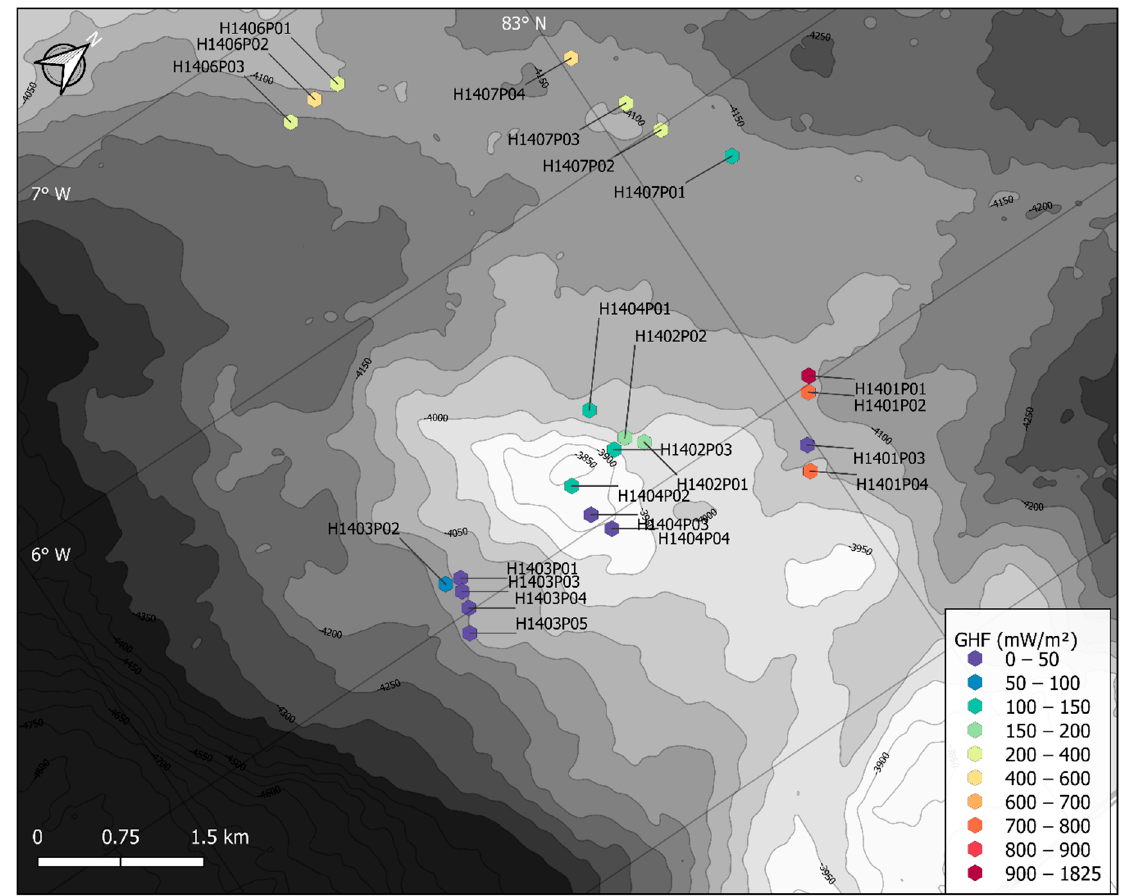
Figure 13. Close up of the Aurora Vent Field region shown in Figure 12. Geothermal heat flow sites (Table 1) are strongly heterogeneous over a small area, which is characteristic for hydrothermal ventilation.